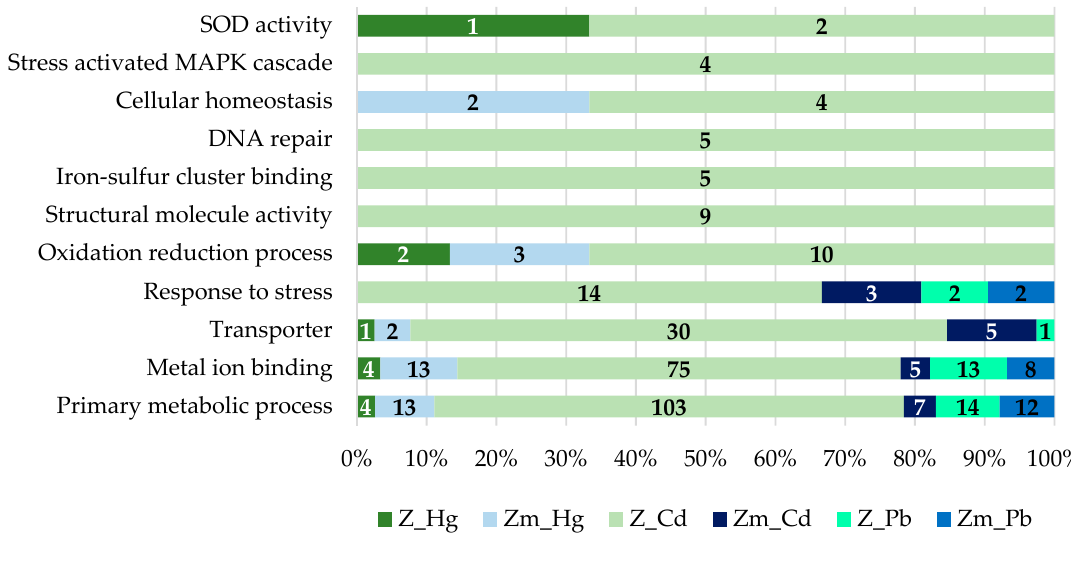
Figure 8. GO annotation of the proteins increased in abundance (fold change ± 1.5, p < 0.05) in E. gracilis Z- and Zm- strains treated with the heavy metals Cd, Hg, and Pb. The proteins were categorized into different sets and denoted by bars specified with numbers (normalized to the total number).